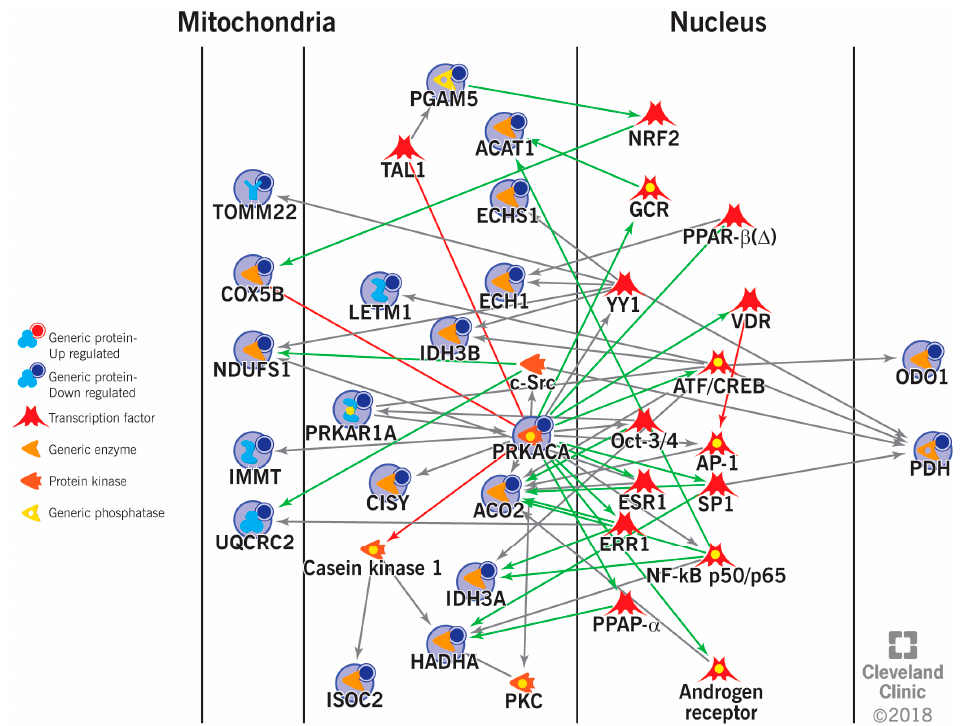
Figure 2. Interaction between the di ff erentially expressed proteins and transcriptional factors in varicocele patients with mitochondrial dysfunction. TOMM22: mitochondrial import receptor subunit TOM22 homolog, COX5B: cytochrome c oxidase subunit 5B, mitochondrial, NDUFS1: NADH-ubiquinone oxidoreductase 75 kDa subunit, mitochondrial, IMMT: NADH-ubiquinone oxidoreductase 75 kDa subunit, mitochondrial, UQCRC2: cytochrome b-c1 complex subunit 2, mitochondrial, PGAM5: serine / threonine-protein phosphatase PGAM5, mitochondrial,